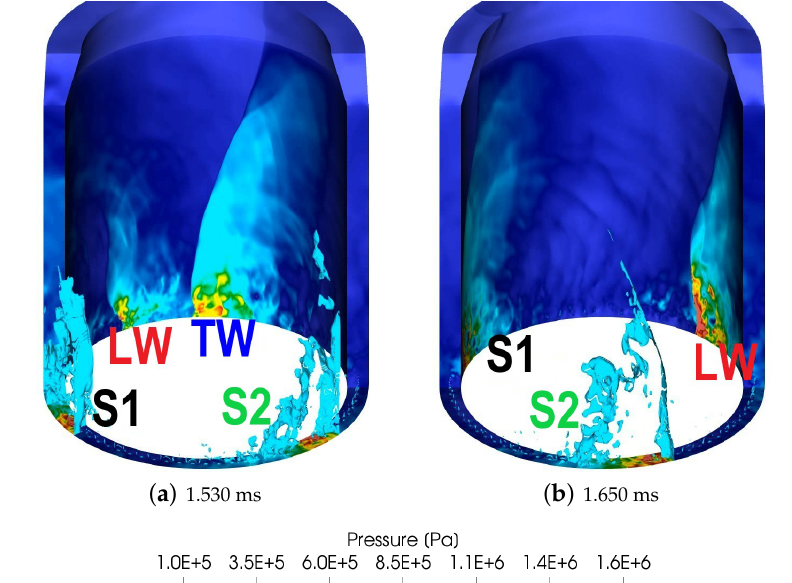
Figure 10. 3D simulation isometric pressure contour of a four to three detonation wave DMT at approximately 1.530 ms and 1.650 ms, with annotated detonation waves: steady wave 1 (S1), steady wave 2 (S2), leading wave (LW), and trailing wave